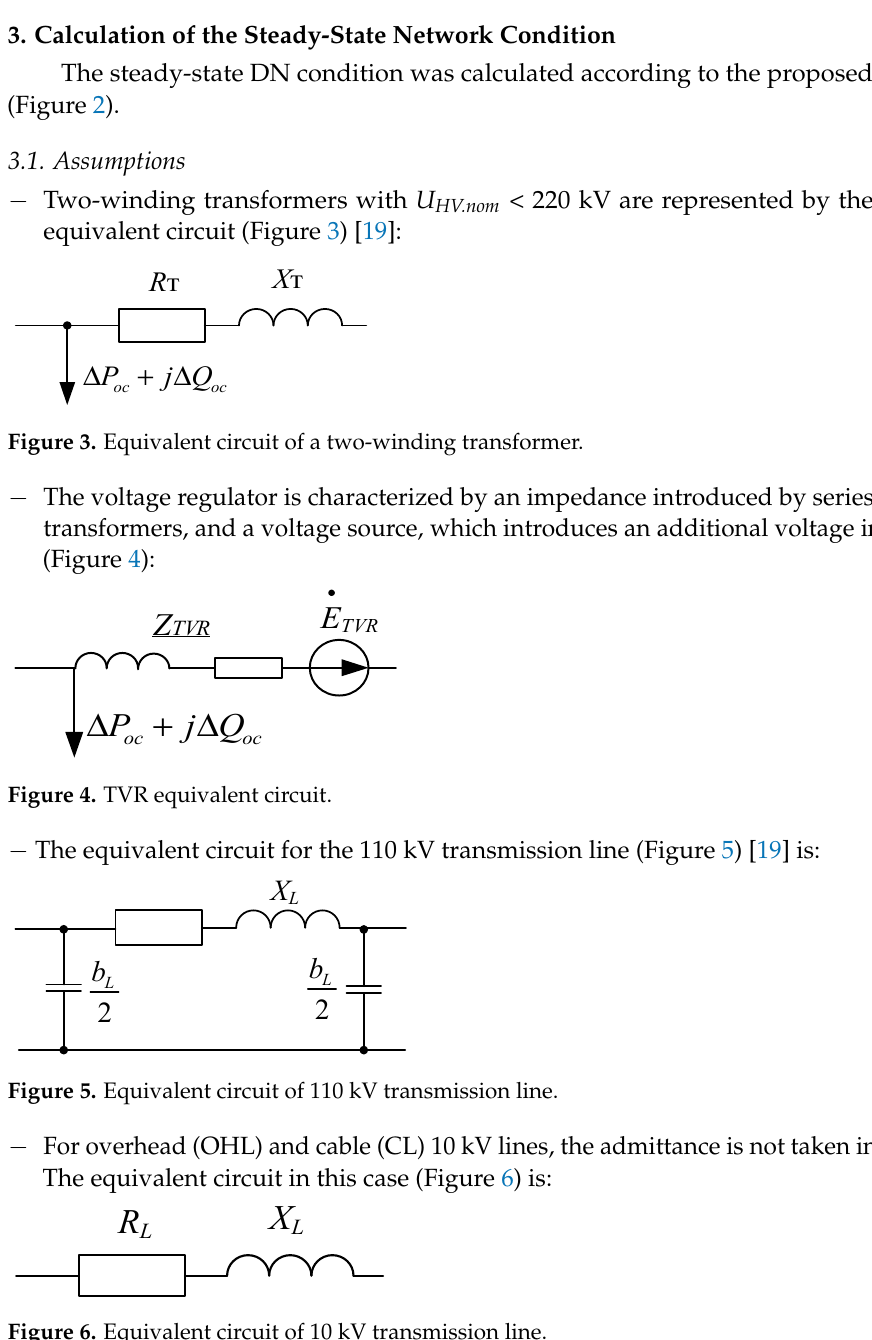
Figure 6. Equivalent circuit of 10 kV transmission line.